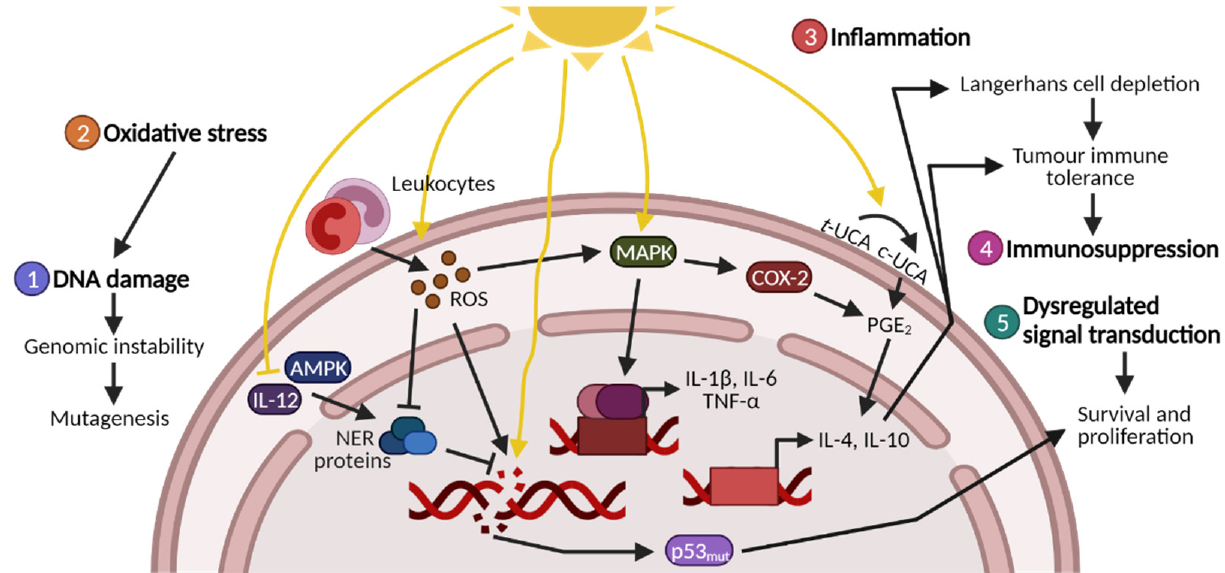
Figure 2. Crosstalk linking UV-induced events: DNA damage, oxidative stress, inflammation, immunosuppression and dysregulated signal transduction as presented in Figure 1. All five events are involved in crosstalk, creating an environment that promotes photocarcinogenesis. Abbreviations: AMPK: AMP-activated protein kinase, AP-1: activator protein 1, COX-2: cyclooxygenase 2, IL: interleukin, MAPK: mitogen-activated protein kinase, NER: nuclear excision repair, PGE 2 : prostaglandin E 2 , ROS: reactive oxygen species, TNF: tumour necrosis factor, t ( trans )/ c ( cis )-UCA: urocanic acid.